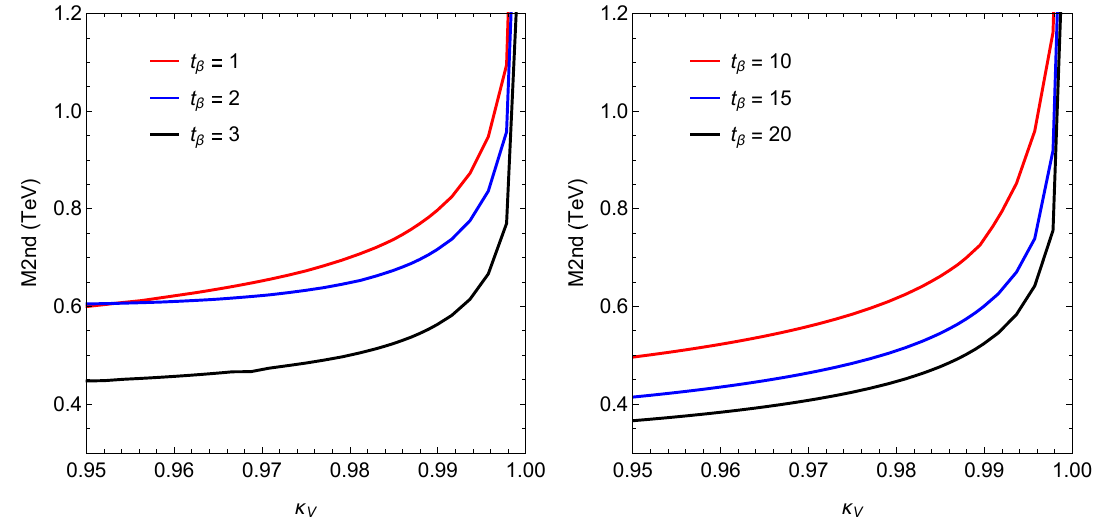
Figure 2 . Upper limit on M 2nd = Min( m of κ V in the 2HDMs with t β = 1 , 2 , 3 (left panel) and t β = 10 , 15 , 20 (right